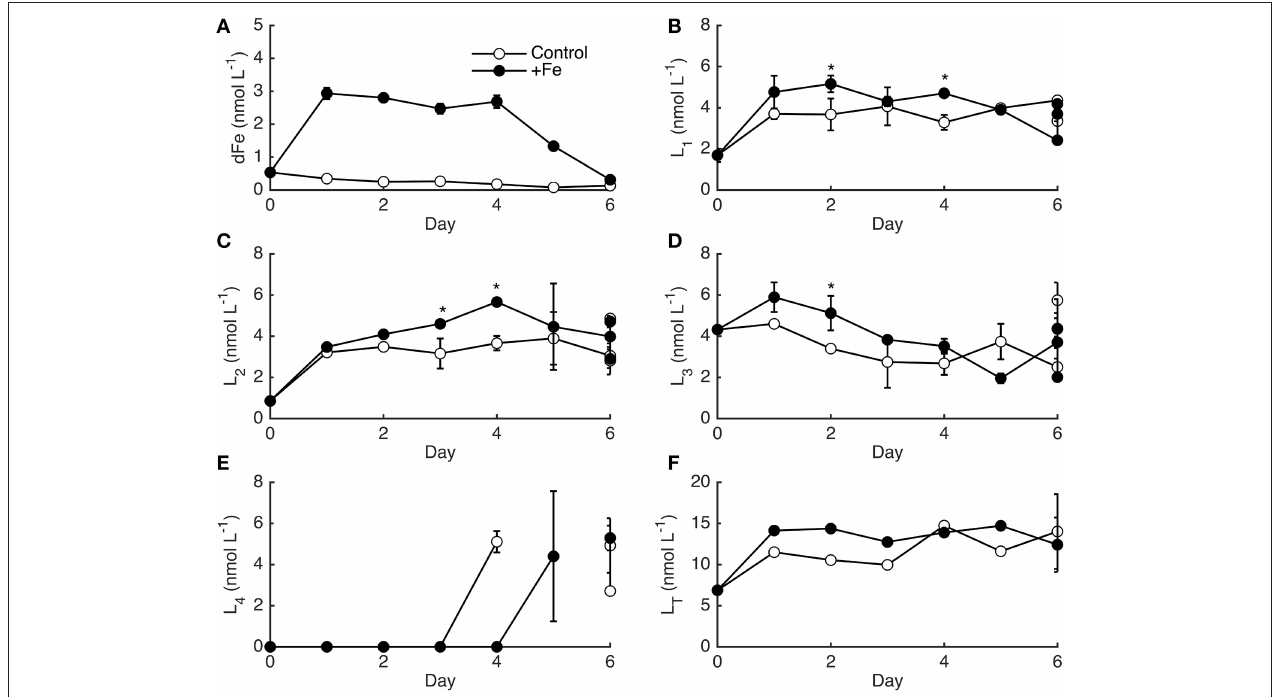
FIGURE 4 | The dFe (A) and ligand data (B–F) for incubation experiment 1 in controls (open circles) and + Fe (closed circles) treatments. Error bars represent the standard deviation between the two linearization techniques employed, except on day 6 where error bars represent the standard deviation between replicate bottles. The * indicates a significant difference in ligand concentrations on that day when the standard deviation between replicate bottles observed on day 6 are considered ( t- test, p < 0.05 ).